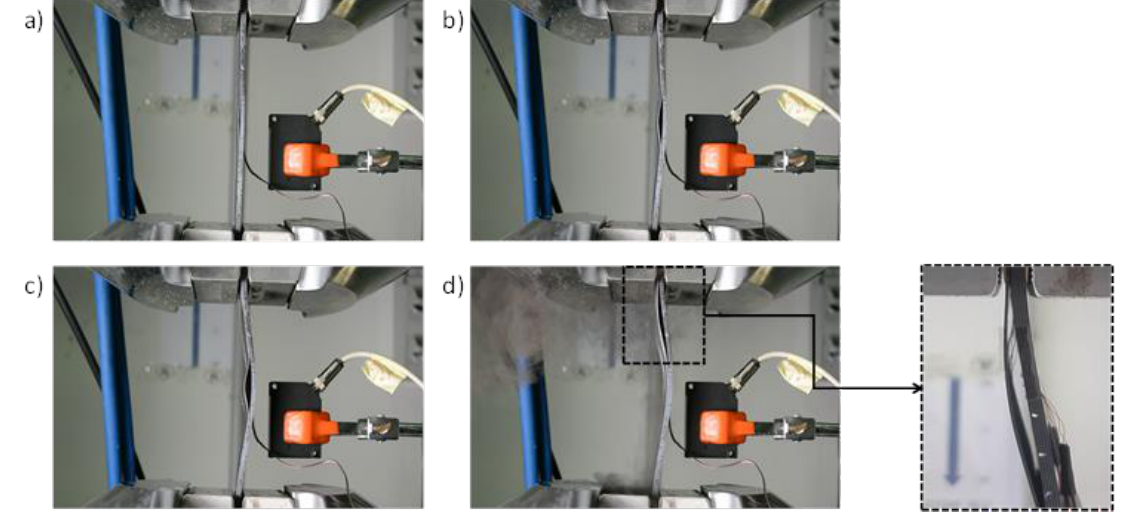
Figure 14. Specimen sensitive to fibre bridging deformed shapes at ( a ) delamination onset, ( b , c ) intermediate delamination state and ( d ) complete delamination.